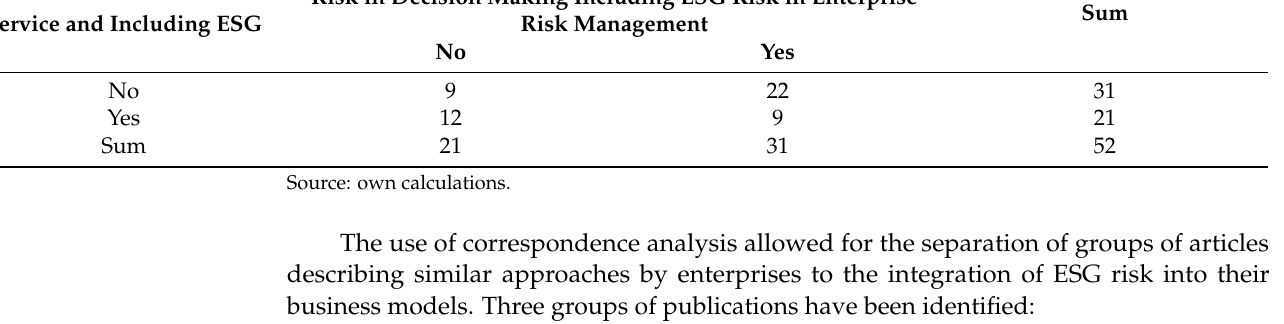
Type of Publi- How ESG Risk How ESG Risk cation Is Incorporated? cation Is Incorporated?